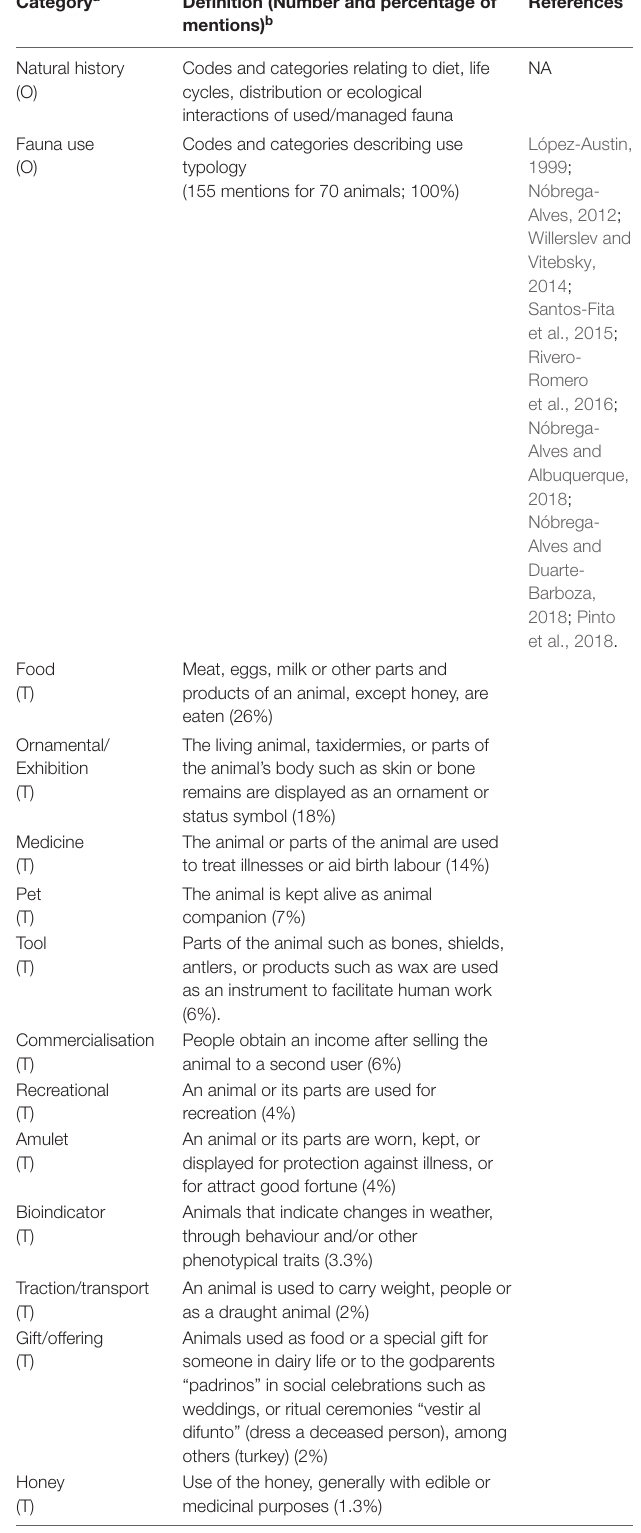
TABLE 1 | Organisational categories and references of theoretical frames used for analysing the information generated in this